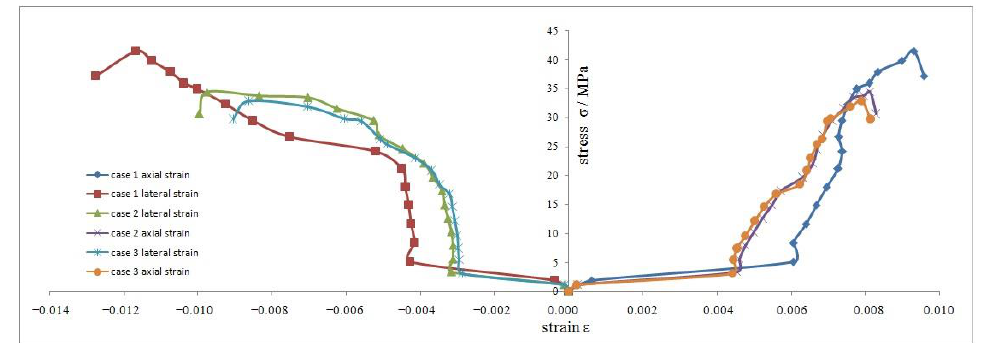
Figure 14. Stress-strain curves of the three case models in uniaxial compression simulation experiments.